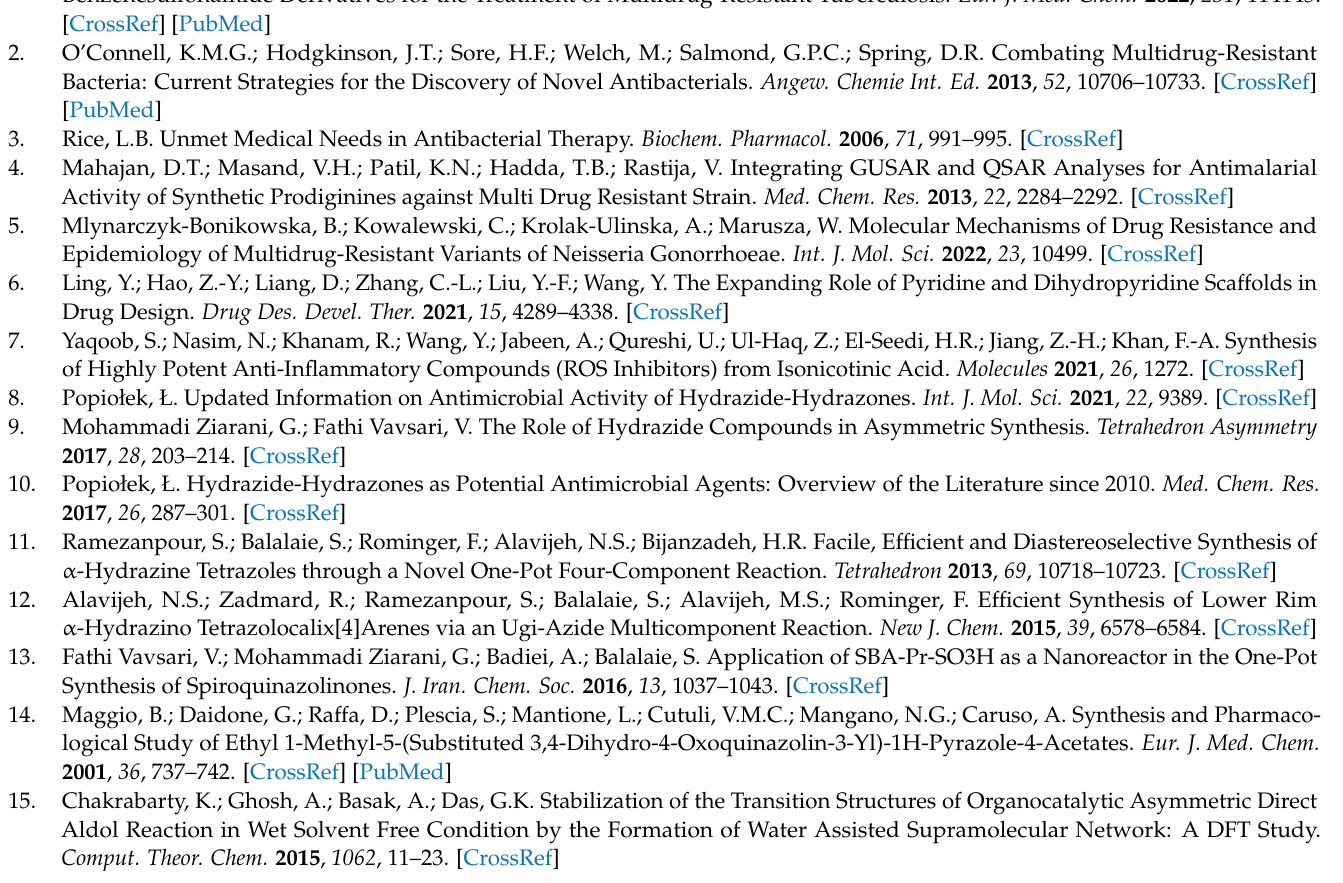
48 hours; Table S4: Comparison of percent hemolysis % ( ± S.D) observed for the compounds 4 and 6